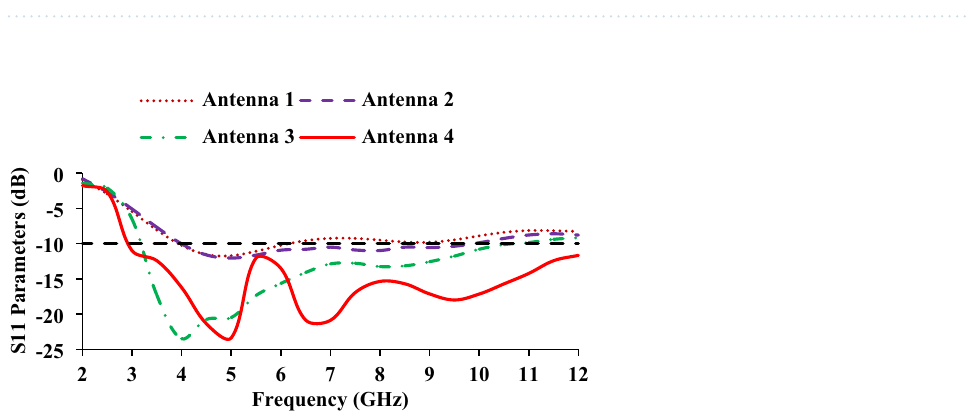
Figure 4. Reflection coefficients of the evolution